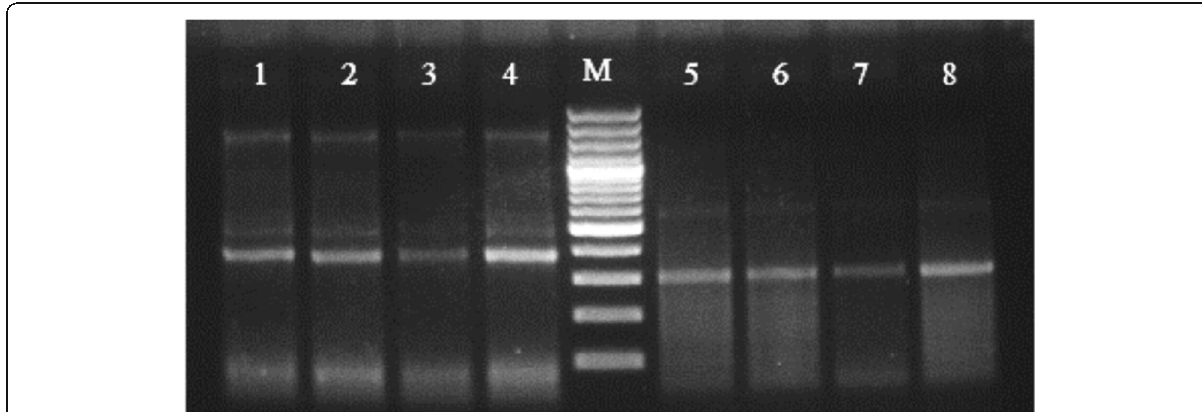
Fig. 1 Genotypes of the C/G polymorphism at the – 1214-bp SDH promoter region determined by allele-specific PCR detection (ASO-PCR) and analyzed by 2% agarose gel electrophoresis, stained with ethidium bromide, and viewed under gel documentation system. Lane M is the (100 bp) DNA ladder; lanes 1 – 4 show the result of amplification with primer specific to the G allele at 494 bp and lanes 5 – 8 with primer specific to the C